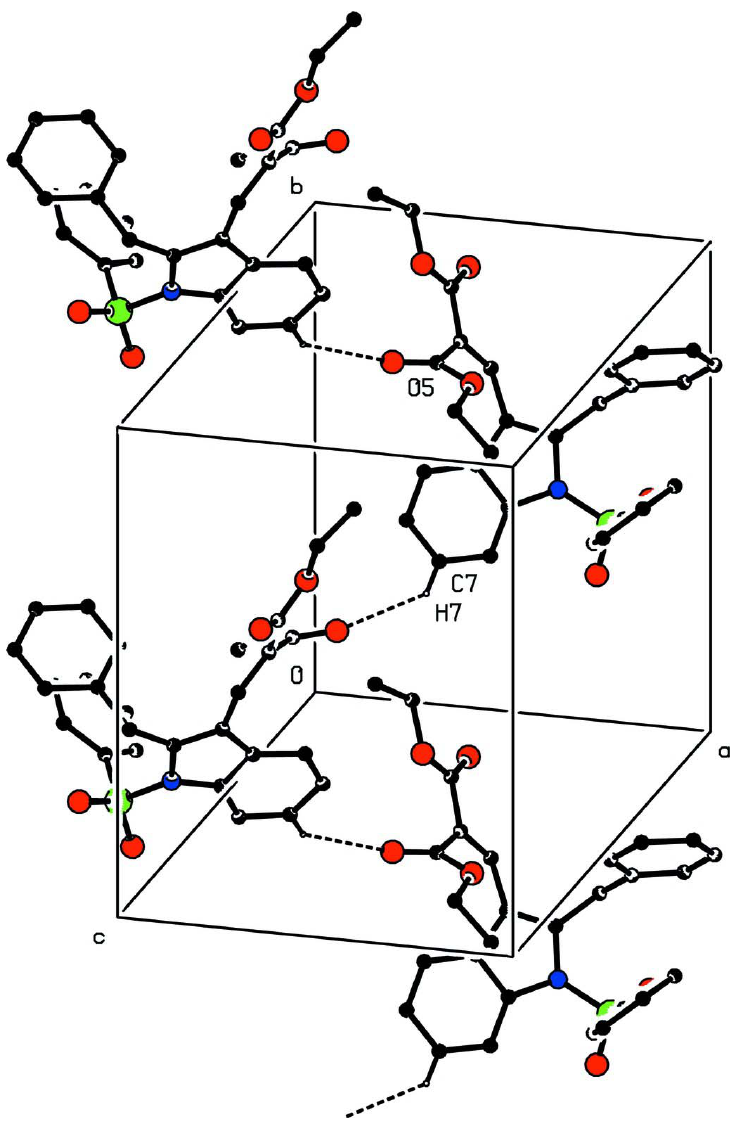
Crystal packing of the title compound. H atoms not involved in hydrogen bonding have been